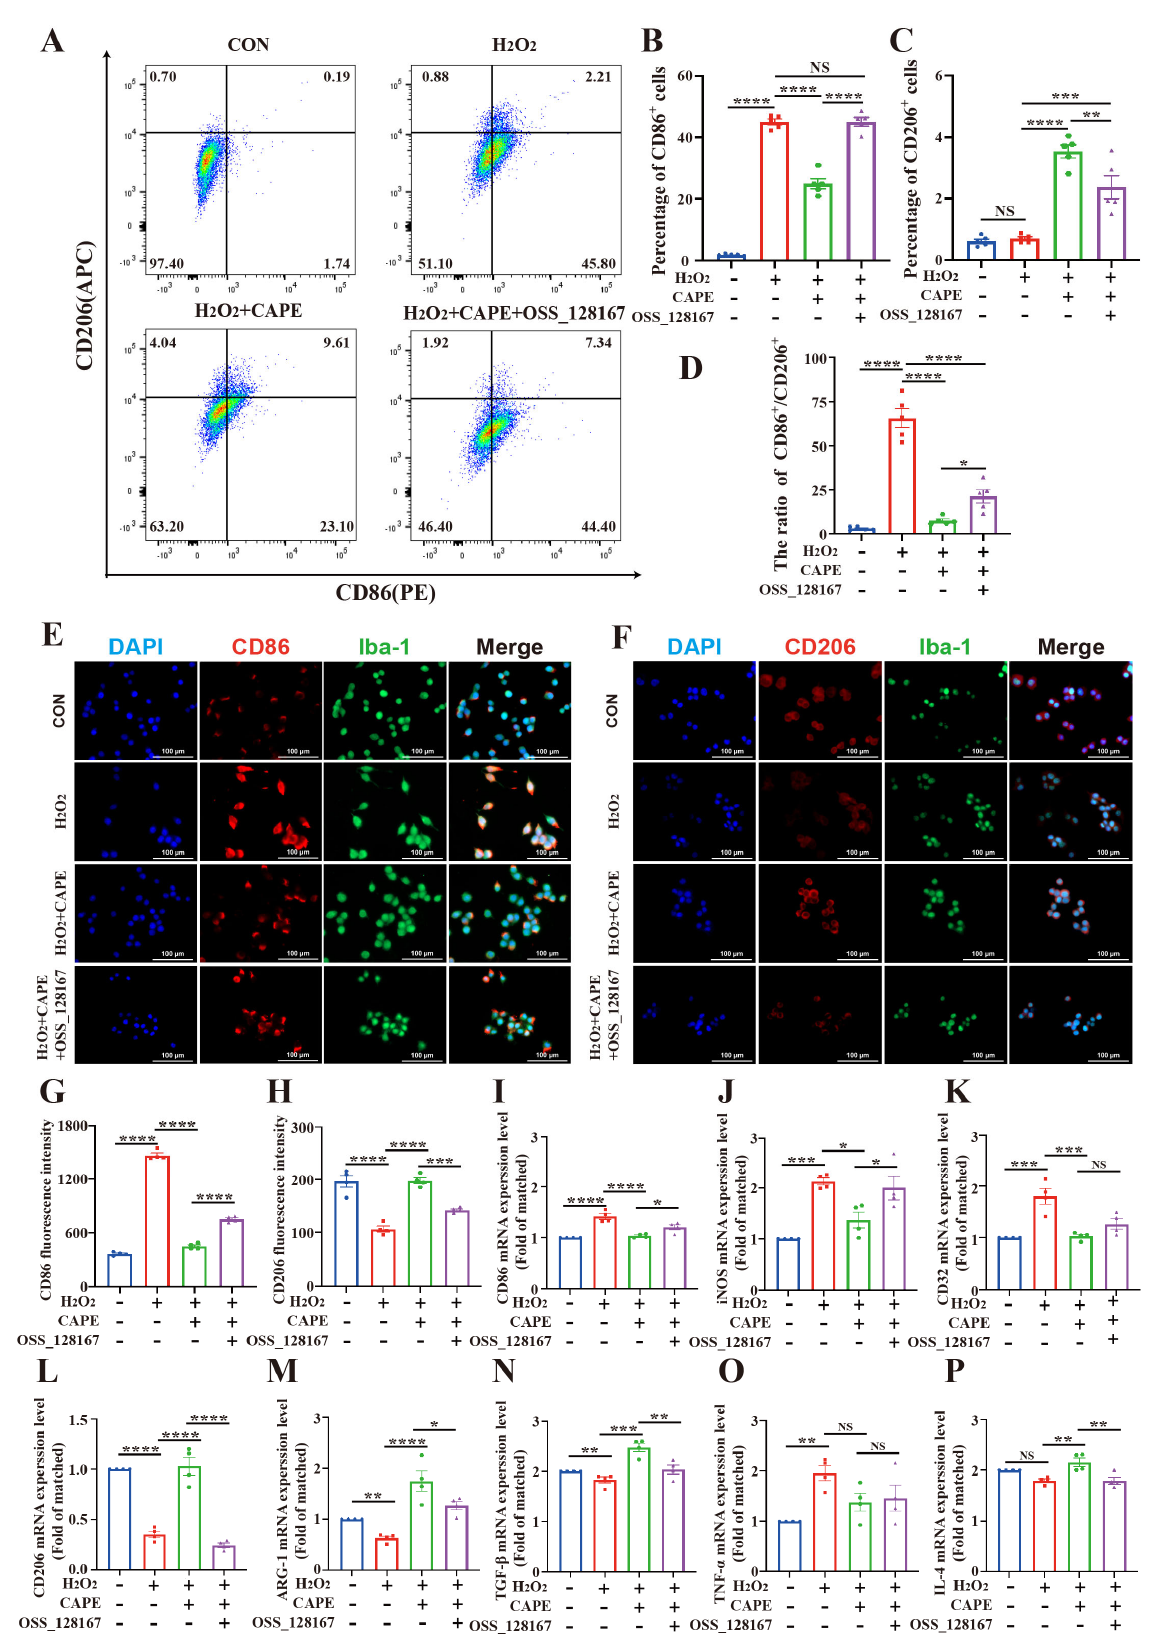
Figure 9. CAPE promotes the switch of H 2 O 2 -induced BV2 cells from the M1 to the M2 type through activating Sirt6. ( A ) Representative fl ow cytometry analysis of BV2 cells induced by four conditions. ( B ) Quanti fi cation of the percentage of CD86 + cells after treatment with four conditions (one-way ANOVA, p value < 0.0001; n = 5 per group). ( C ) Quanti fi cation of the percentage of CD206 + cells after treatment with four conditions (one-way ANOVA, p value < 0.0001; n = 5 per group). ( D ) The ratio of CD86 + /CD206 + cells after treatment with four conditions (one-way ANOVA, p value < 0.0001; n = 5 per group). ( E ) Immuno fl uorescence staining of CD86 and Iba1 in BV2 cells after treatment with the four conditions. ( F ) Immuno fl uorescence staining of CD206 and Iba1 in BV2 cells after treatment with the four conditions. ( G ) Quanti fi cation of CD86 fl uorescence intensity mean value in the four conditions (one-way ANOVA, p value < 0.0001; n = 4 per group). ( H ) Quanti fi cation of CD206 fl uo- rescence intensity mean value in the four conditions (one-way ANOVA, p value < 0.0001; n = 4 per group). ( I ) RT-qPCR analysis of CD86 in BV2 cells under four conditions (one-way ANOVA, p value < 0.0001; n = 4 per group). ( J ) RT-qPCR analysis of iNOS in BV2 cells under four conditions (one- way ANOVA, p value = 0.0004; n = 4 per group). ( K ) RT-qPCR analysis of CD32 in BV2 cells under